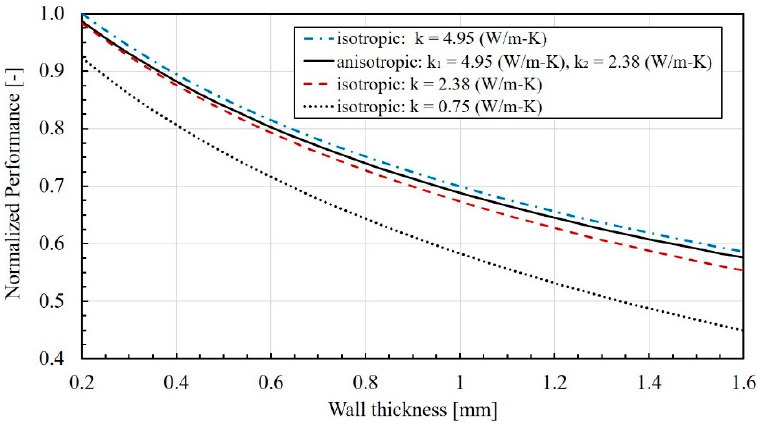
Figure 13. Effect of wall thickness, conductivity, and anisotropy on normalized performance.